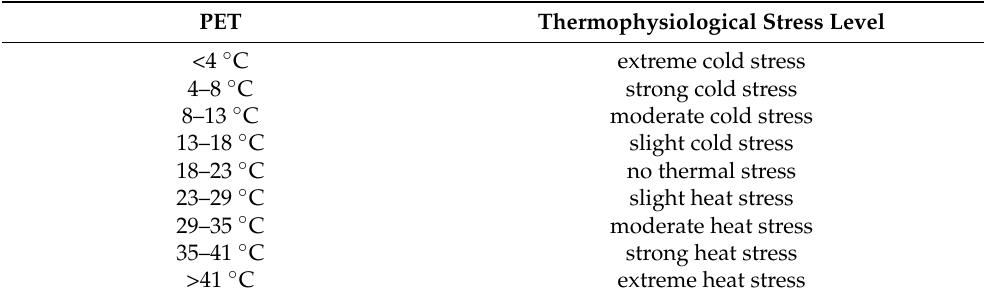
Table 1. Physiologically equivalent temperature (PET) range for the different levels of thermophys- iological stress on standardized human beings for defined activity and clothing [20].